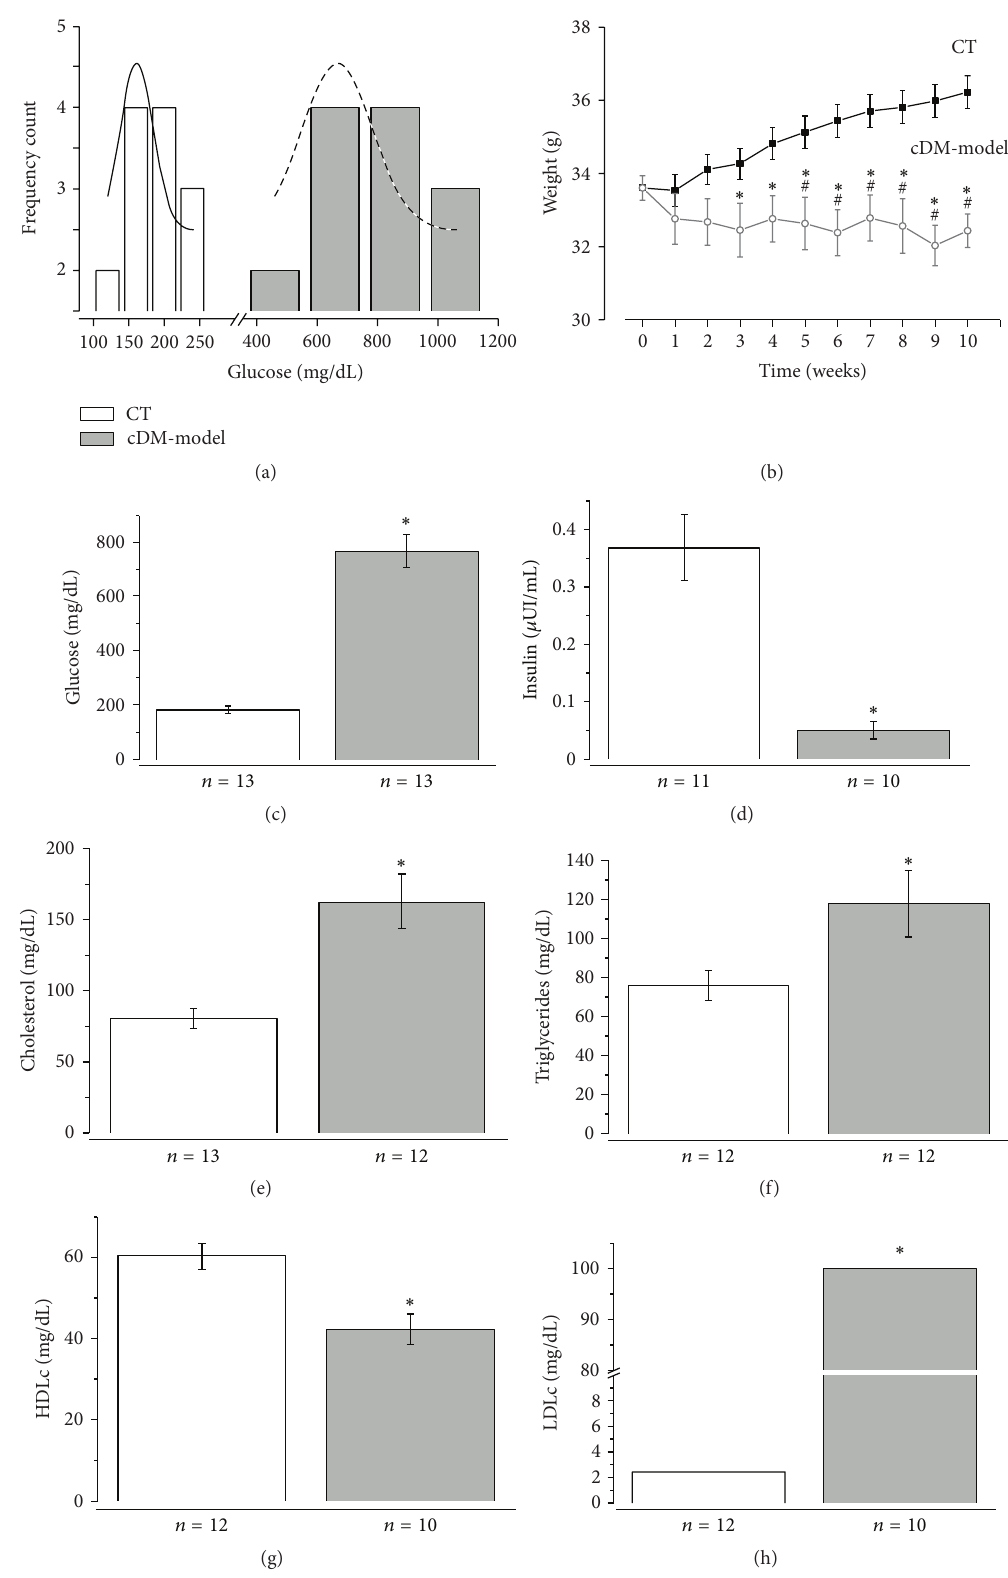
Figure 1: Characterization of chronic diabetes mellitus model. (a) Distributions of glucose plasma. (b) The plot shows that the cDM-model mice are losing weight since the third week after STZ-injection. (c) Increased plasma glucose. (d) Decreased insulin plasma. (e–h) Nonfasting lipid profile (LDL, HDL, total cholesterol, and triglycerides) is altered for the treatment. 𝑛 = animals number, ∗ 𝑝 ( < 0.05) versus control (dark line), and #: versus first weight (grey